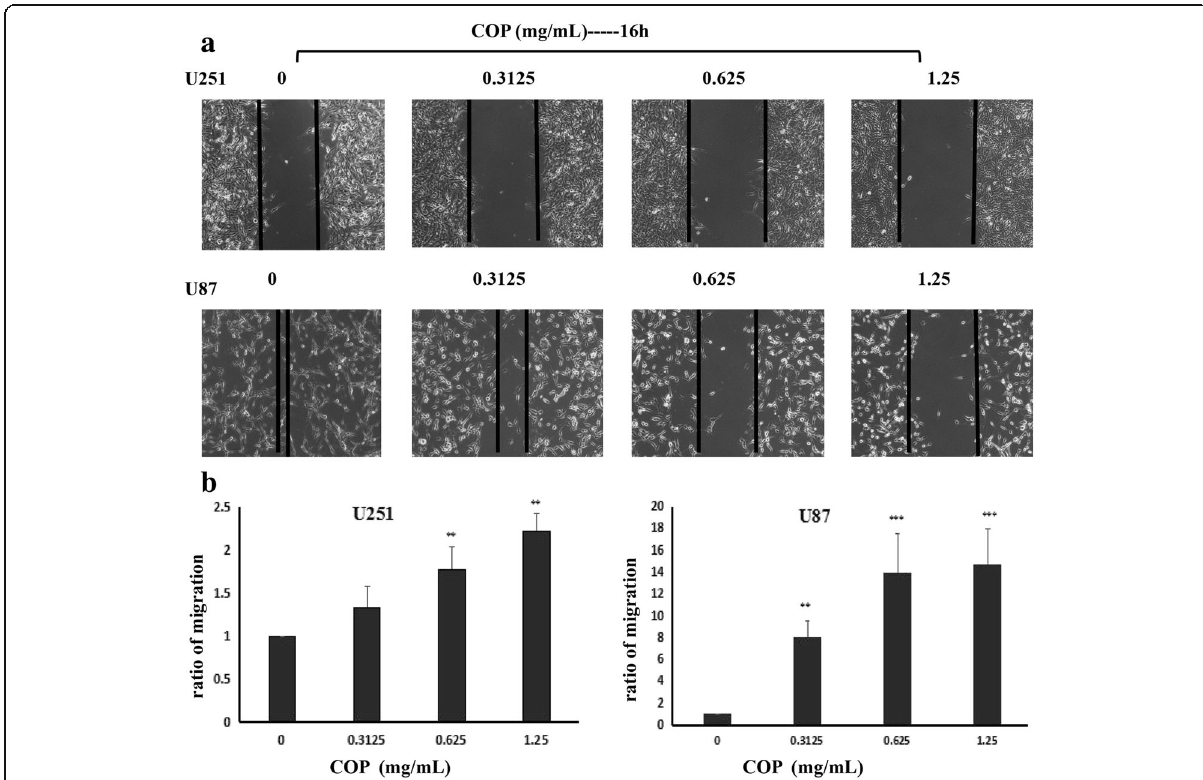
Fig. 4 Effect of COP on Glioma cells migratory ability. a Scratch wound healing assays were performed, and U251 and U87 cells were treated with COP (0, 0.3125, 0.625 and 1.25 mg/ml) for 24 h. Photographs of cell culture dishes are shown. b Migration ratio represent the mean ± SD from 3 independent experiments. *, P < 0.05; **, P < 0.01; ***, P < 0.001 compared with the control